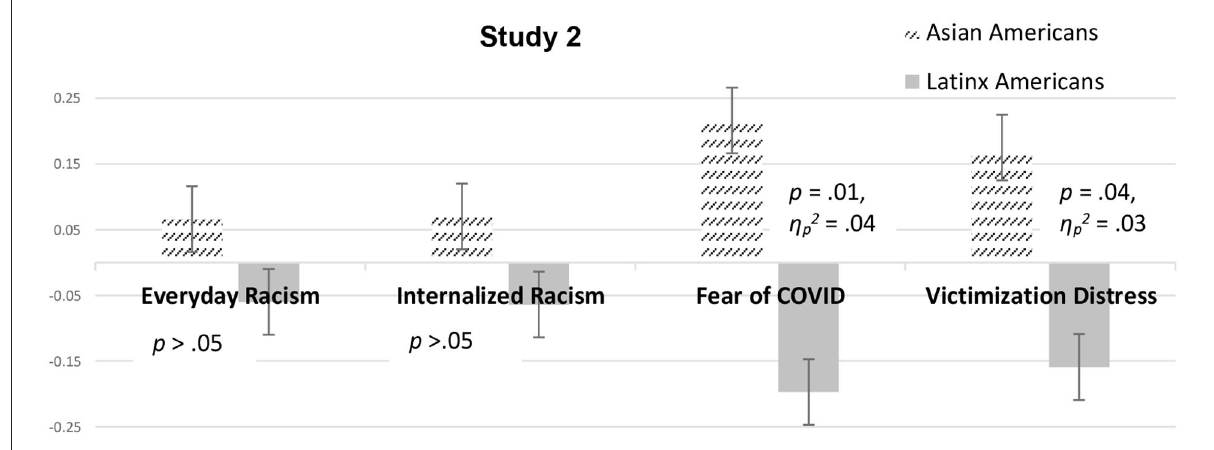
FIGURE4 Psychosocial factor scores for Asian and Latinx Americans across study 2 controlling for covariates. Note . Psychosocial factor scores of Asian and Latinx Americans are shown for everyday racism, internalized racism, fear of coronavirus, and victimization distress (error bars show standard errors), controlling for everyday racism before the pandemic, gender, generation status, and socioeconomic status.